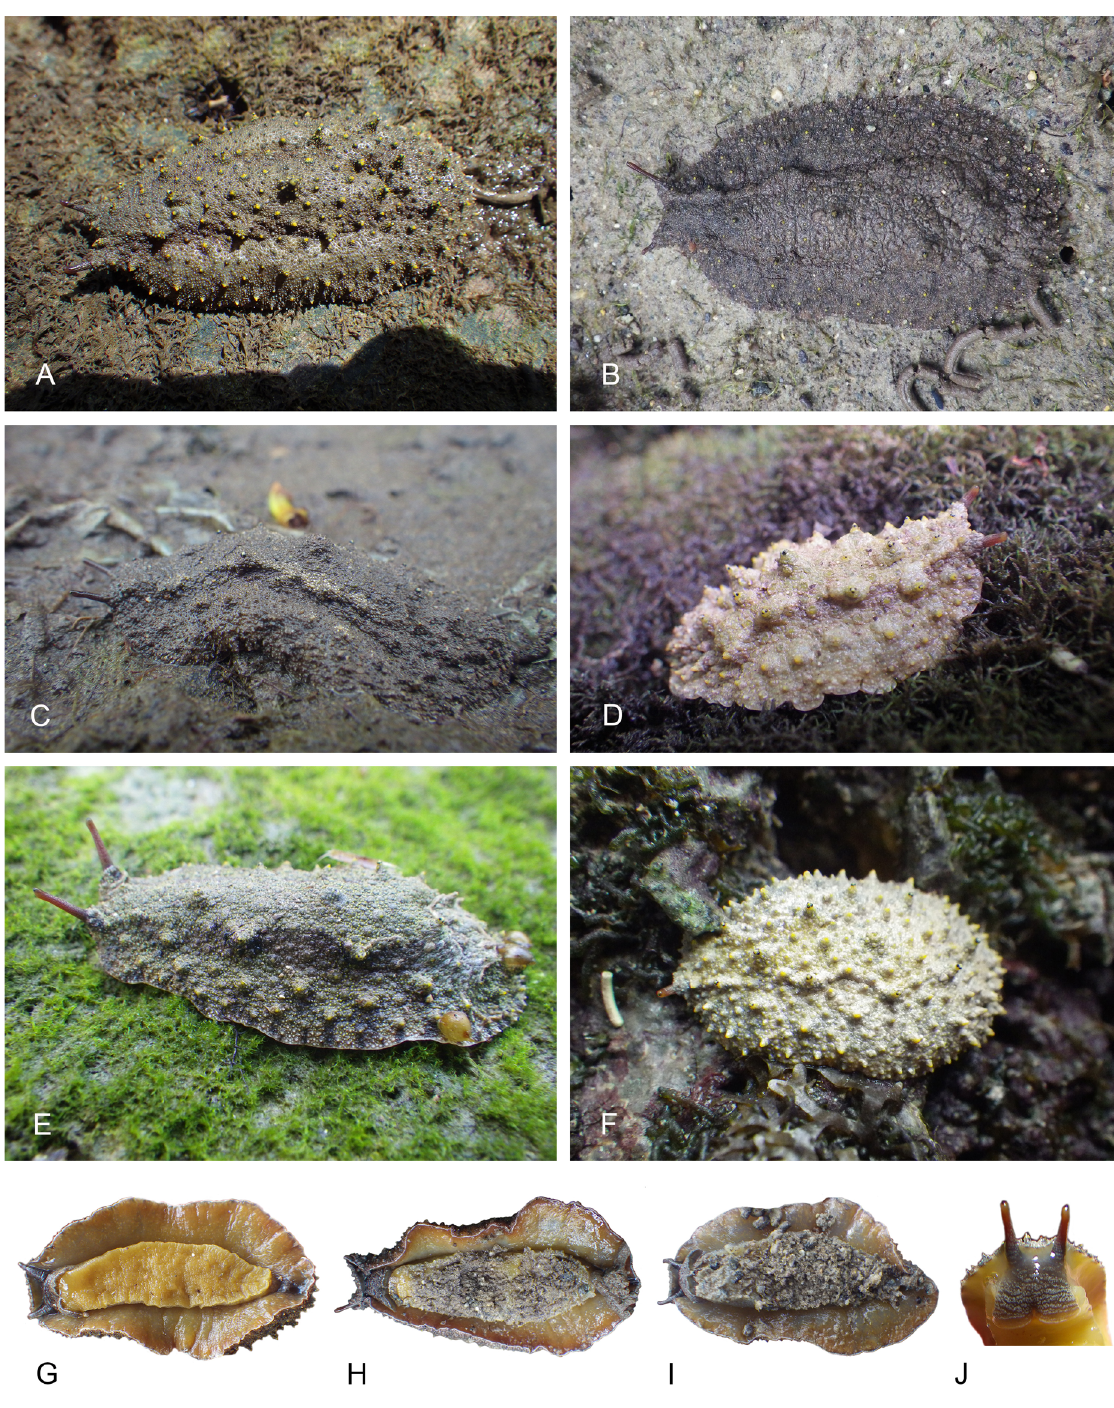
Fig. 32. Paromoionchis boholensis gen. et sp. nov., unit #2, live animals. A . Dorsal view, 37 mm long [2129], Indonesia, Sulawesi (UMIZ 00141). B . Dorsal view, 45 mm long [2851], Indonesia, Ambon (UMIZ 00146). C . Dorsal view, 35 mm long [3117], Indonesia, Bali (UMIZ 00140). D . Dorsal view, 18 mm long [2911], Indonesia, Kei (UMIZ 00149). E . Dorsal view, 40 mm long [2937], Indonesia, Kei (UMIZ 00150). F . Dorsal view, 15 mm long [2903], Indonesia, Kei (UMIZ 00149). G . Ventral view, 45 mm long [2884], Indonesia, Seram (UMIZ 00147). H . Ventral view, same as B. I . Ventral view, 45 mm long [2850], Indonesia, Ambon (UMIZ 00146). J . Frontal view, 17 mm long [2901], Indonesia, Kei (UMIZ